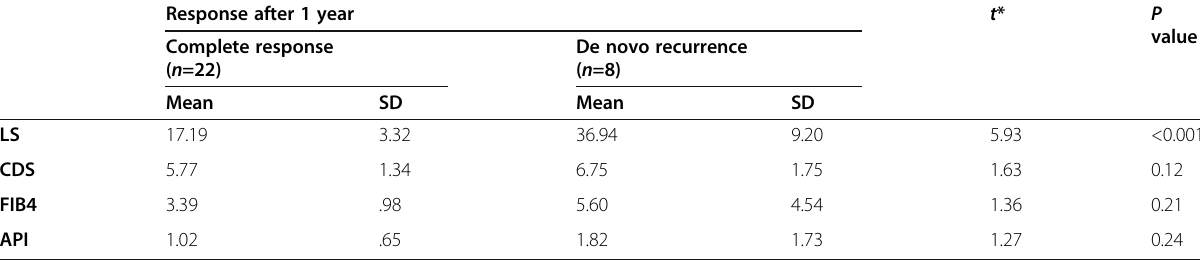
Table 3 Relation between de novo HCC recurrence and noninvasive liver fibrosis tests Response after 1